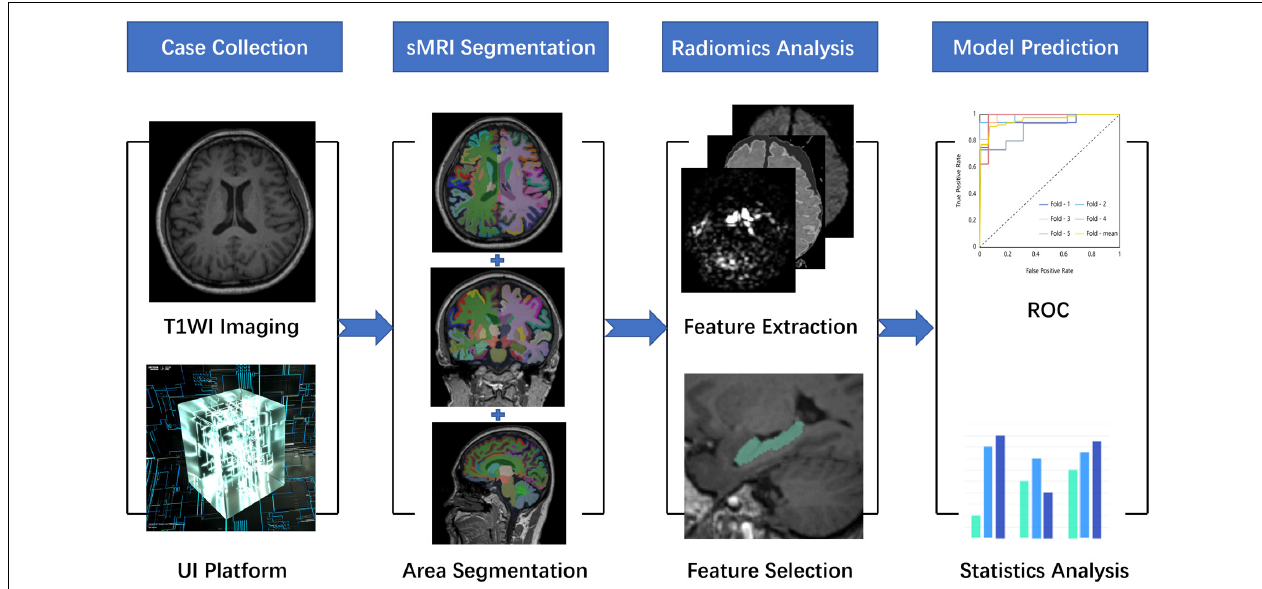
FIGURE 1 | A research map. This study is mainly divided into four parts. The first part is data collection and preprocessing, the second part is whole-brain structure segmentation, the third part is radiomic analysis, and the fourth part is model construction and evaluation.